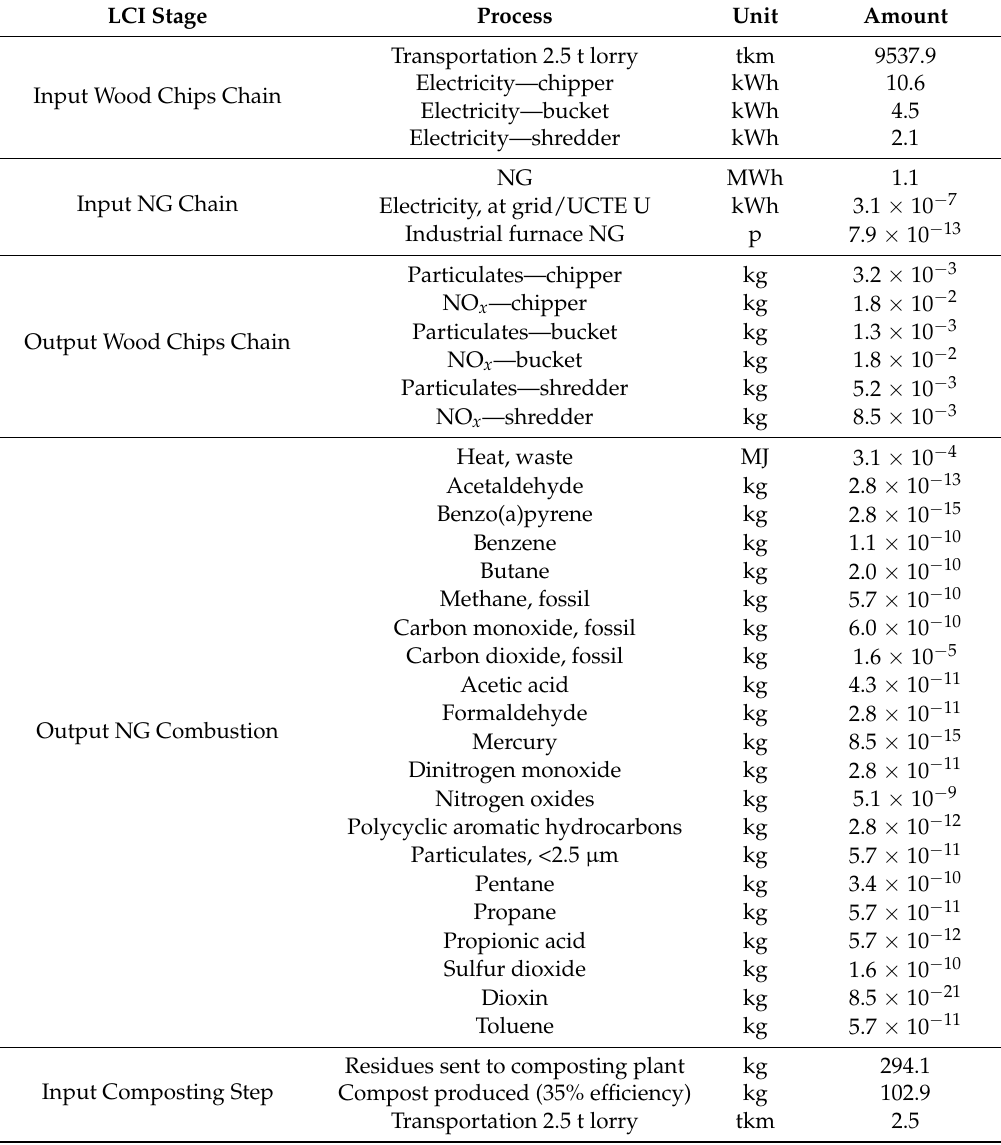
Table 2. Life Cycle Inventory (LCI) for the current heating system scenario. NG: natural